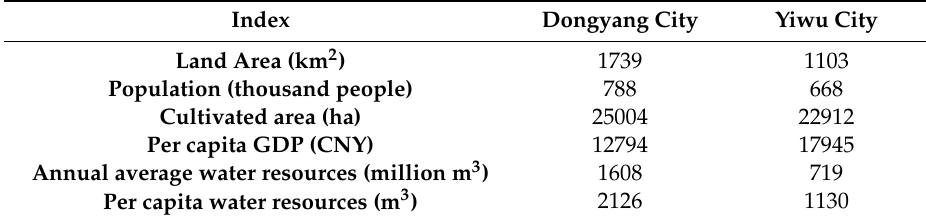
Table 2. The socio-economic and water resources status of Dongyang City and Yiwu City in